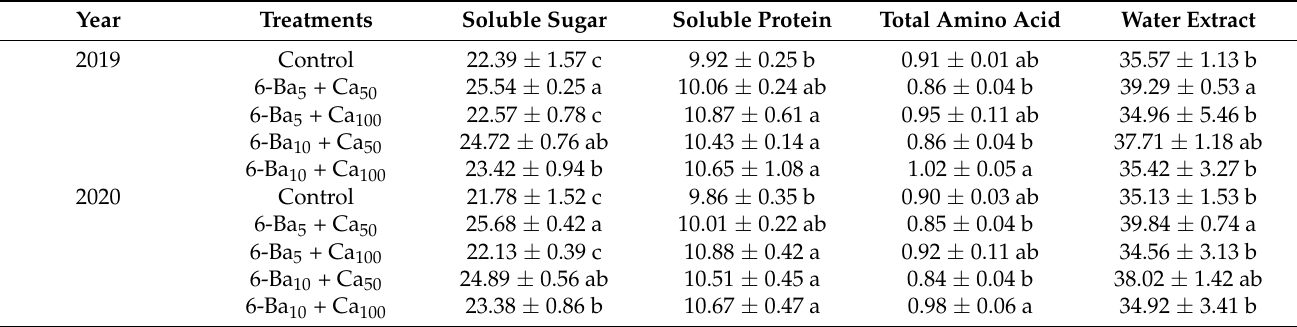
Table 3. Changes of nutritional quality index of Hangbaiju flowers (%).